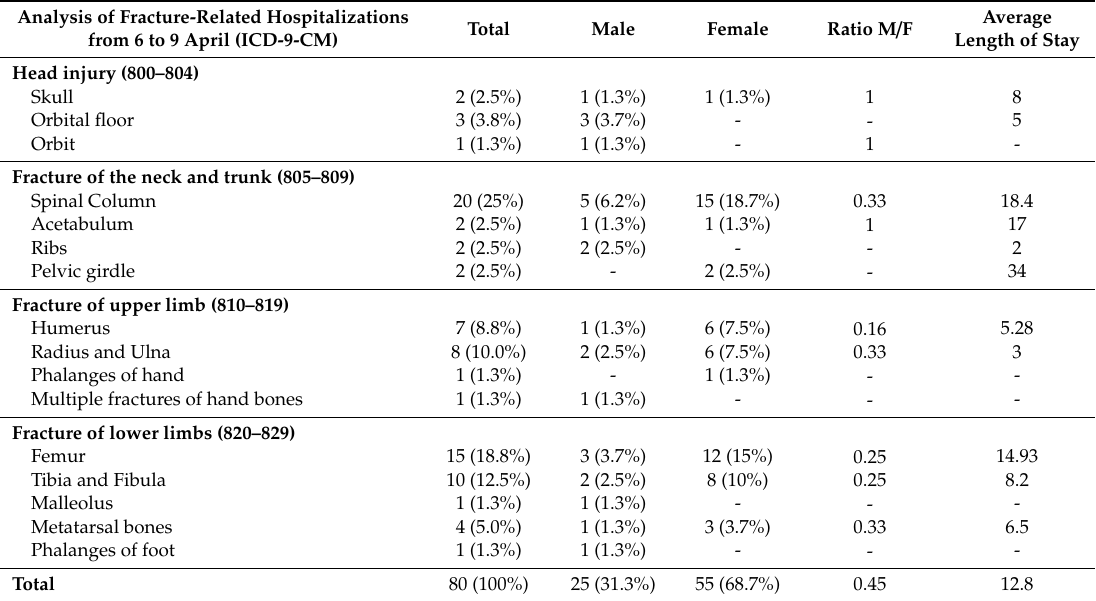
Table 5. Analysis of fracture-related hospitalizations by anatomic site, gender, and average length of